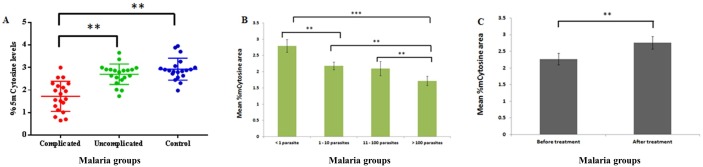
Global methylation estimation by RP-HPLC.A. Global methylation values (5mC) in malaria patients (with and without complications) and controls. Each dot represents the total methylation cytosine content of the individual sample. B. Global methylation values (5mC) in malaria patients (with different parasite levels). C. Global methylation values (5mC) in malaria patients (before and after treatment). Patient blood was collected twice at the time of admission (before medication) and after 7days of treatment. Within the groups mean ± standard error was shown in lines. The aster sign indicates the p value significance. **P<0.01, *P<0.05.